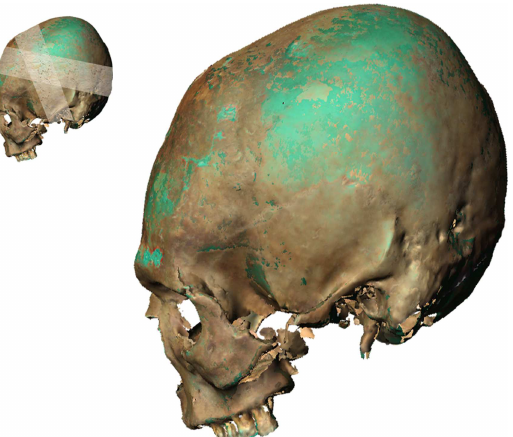
Fig 7. Hungarian cranium used in this study demonstrating the two bandage technique of annular modification. In additionto the circularbandages,a vertical bandagein the regionof the bregma restricts cranial heightand results in a bregmatic depression. The orientation of the craniumis that used in the eigenshape analysisin this